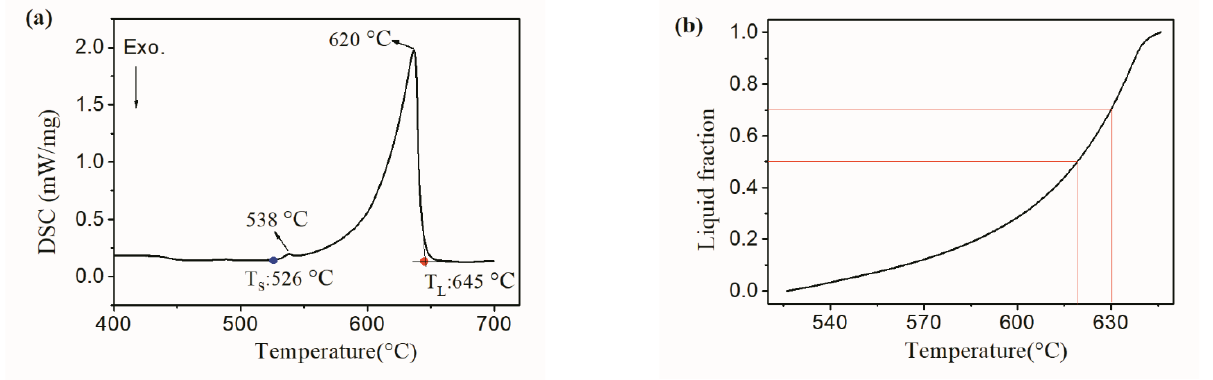
Figure 2. ( a ) DSC curve and ( b ) calculated curve of liquid fraction versus temperatures using the Scheil assumption for the 7075 aluminium alloy sample from 400 °C to 700 °C.